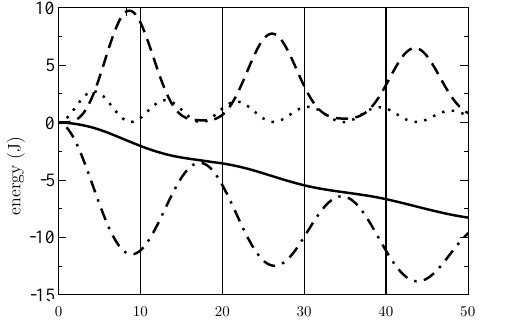
Fig. 9. Time evolution of E 1 (dotted line), E 2 (dashed line), poten- tial energy change E p (dashed dotted line) and the sum of the three (full